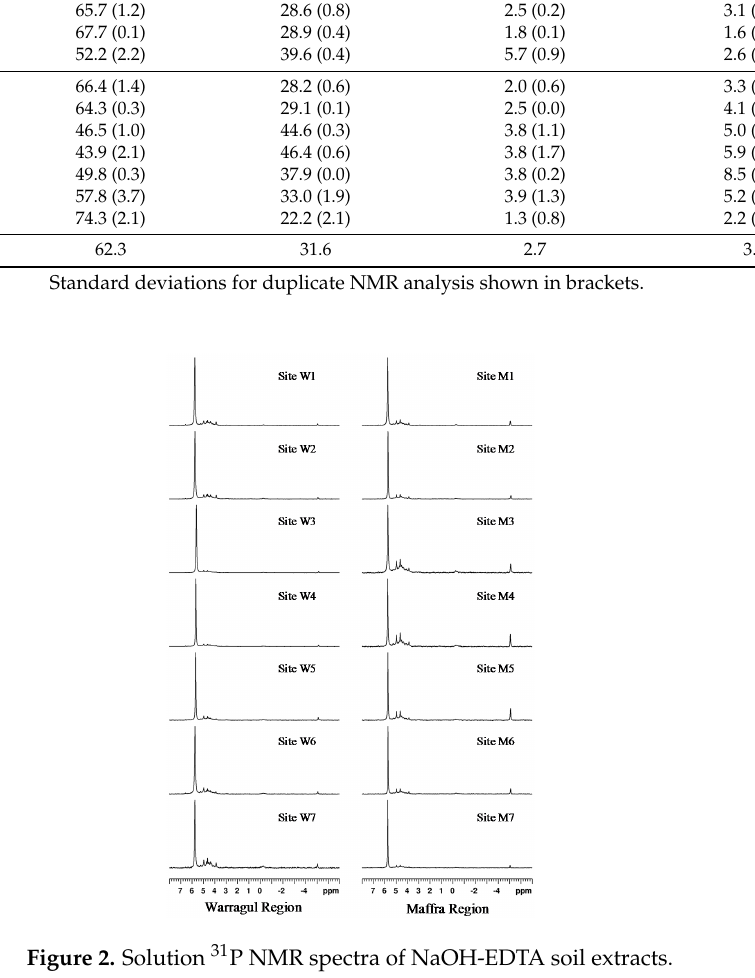
Table 4. The percentage distribution of the total 31 P NMR signal across four diagnostic chemical regions.